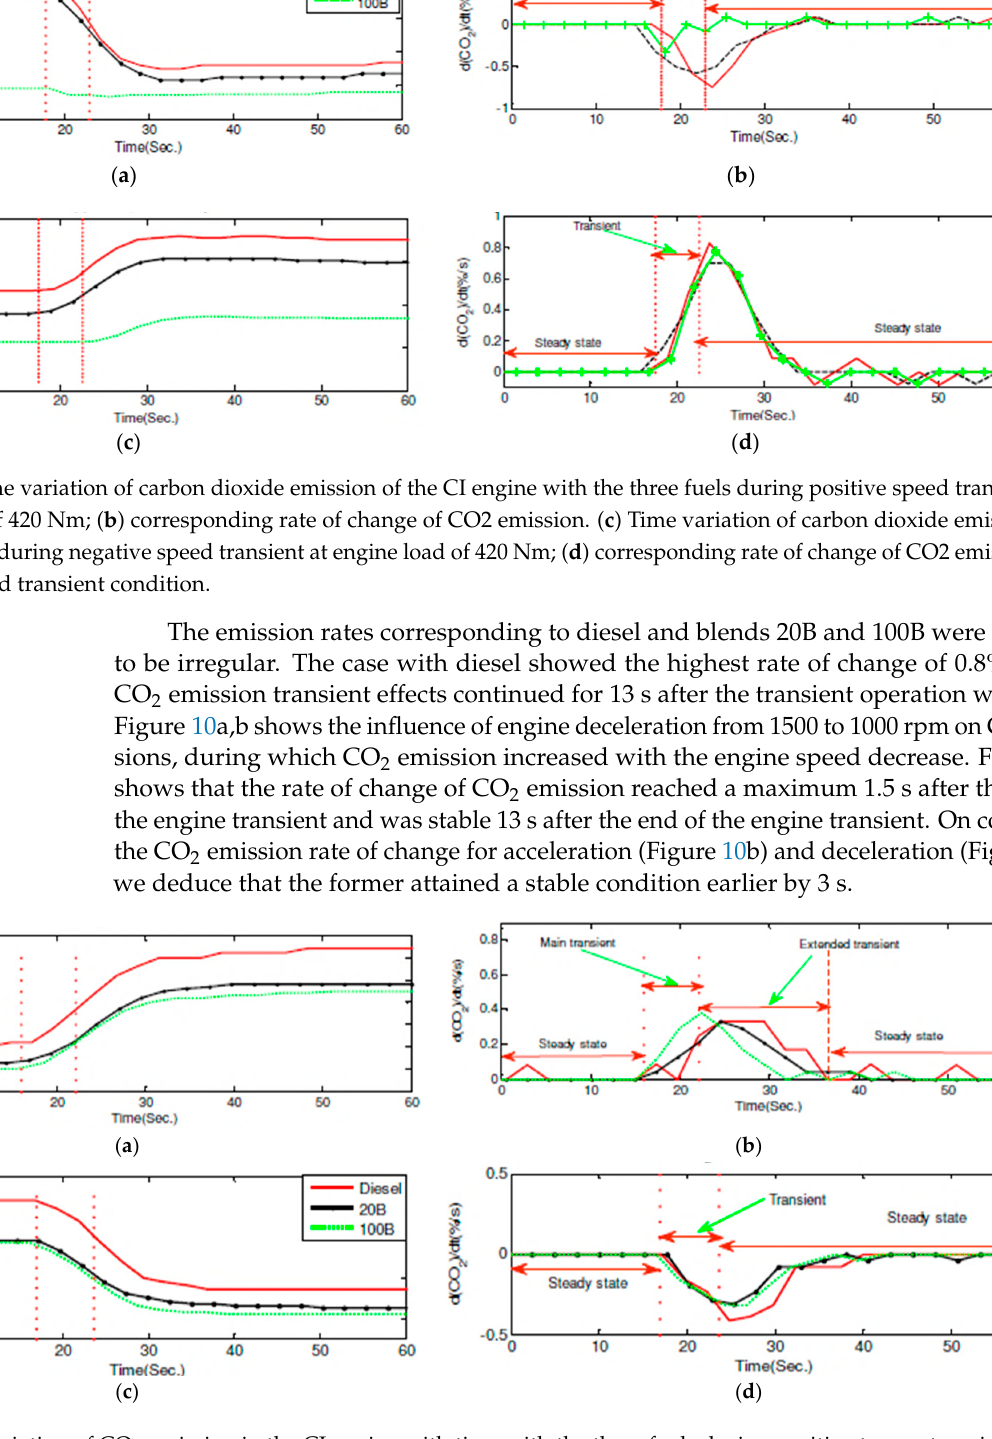
Figure 10. ( a ) Variation of CO 2 emission in the CI engine with time with the three fuels during positive torque transient at 1500 rpm; ( b ) rate of change of CO 2 emission with time. ( c ) Variation of CO2 emission of CI engines with time during positive torque transient at 1500 rpm; ( d ) corresponding rate of change of CO 2 emissions during positive torque transient conditions.